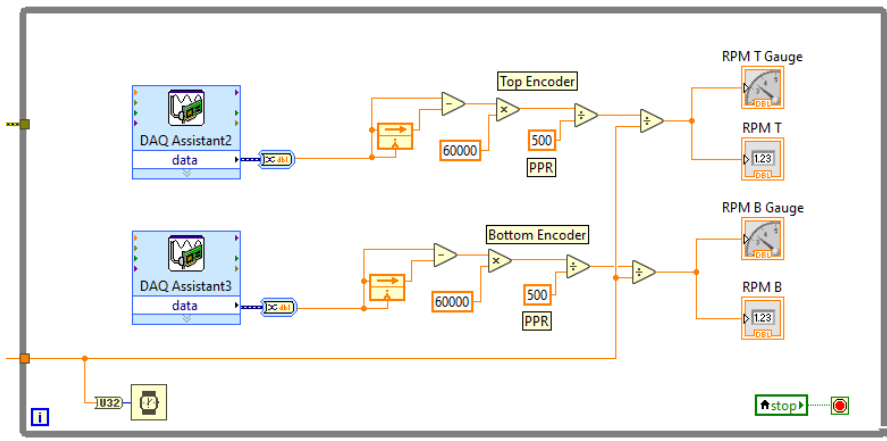
Figure 14. Rotary encoder loop.